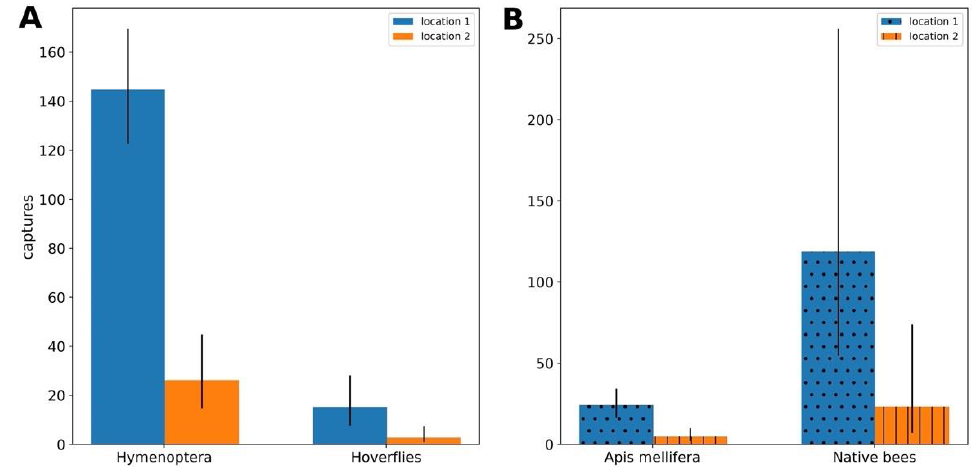
Figure 4. Comparison of pollinators captured at the location with remnant native vegetation (location 1, blue bars) and the urban, residential location (location 2, orange bars). Panel ( A ): mean number of hymenopterans and hoverflies captured at both sites. There were significantly more hymenopterans captured in location 1 than in location 2 ( p < 0.001), with significantly more hymenopterans captured at both locations ( p < 0.001). Panel ( B ): mean number of European honeybees ( Apis mellifera ) and native bees captured at the two locations. Significantly, more native bees than European honeybees were captured at both locations ( p < 0.001), with more captures being made at the location with remnant native vegetation ( p < 0.001). Error bars represent 95 % confidence intervals of the mean in all cases. Refer to the result section for details on the statistical analyses.